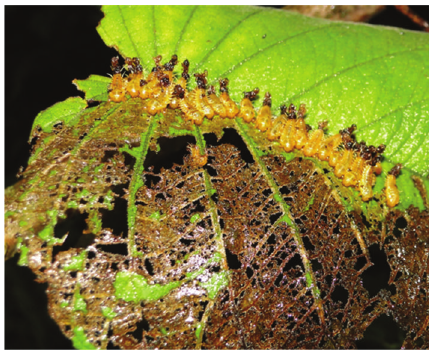
Figure 3: Leaf with signs of herbivory caused by Omaspides palli- dipennis Boheman, 1854 (Chrysomelidae) in first stages. A fragment of Atlantic Forest (Floresta Nacional de Passa Quatro, Minas Gerais State, Brazil).